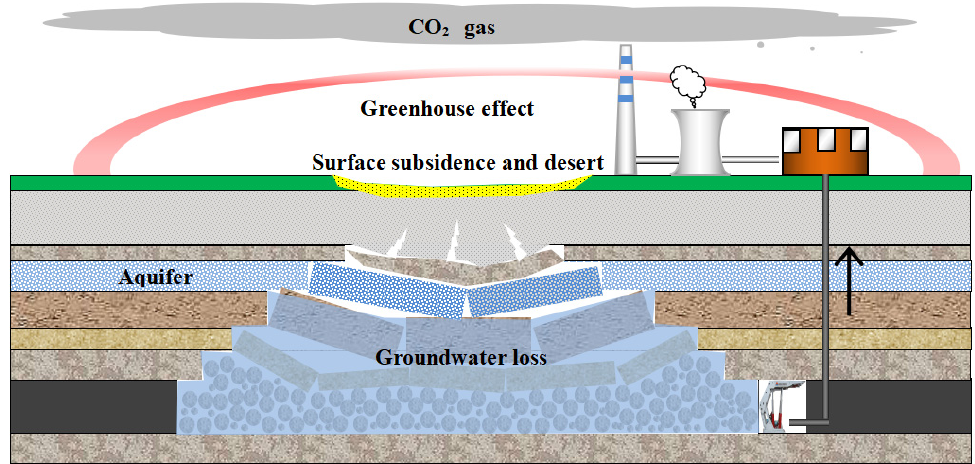
Figure 1. Ecological and environmental effects of the traditional coal exploitation and utilization mode in large coal power bases.